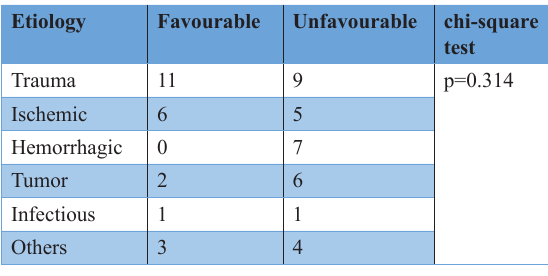
Table 6. Relation between etiology and outcome